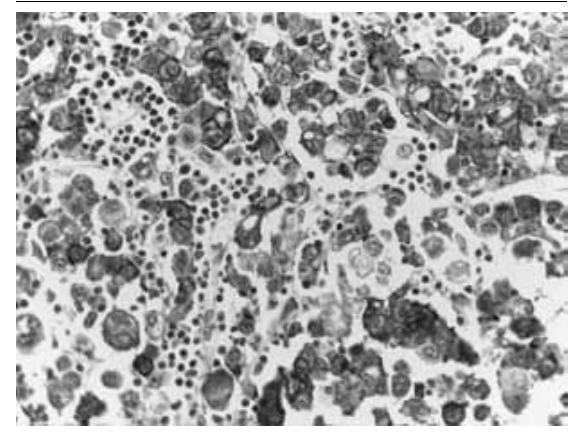
figurE – Diffuse-type gastric carcinoma HER2 3+ with signet-ring cells showing strong membrane staining (20×) HER2: human epidermal growth factor receptor-type 2.